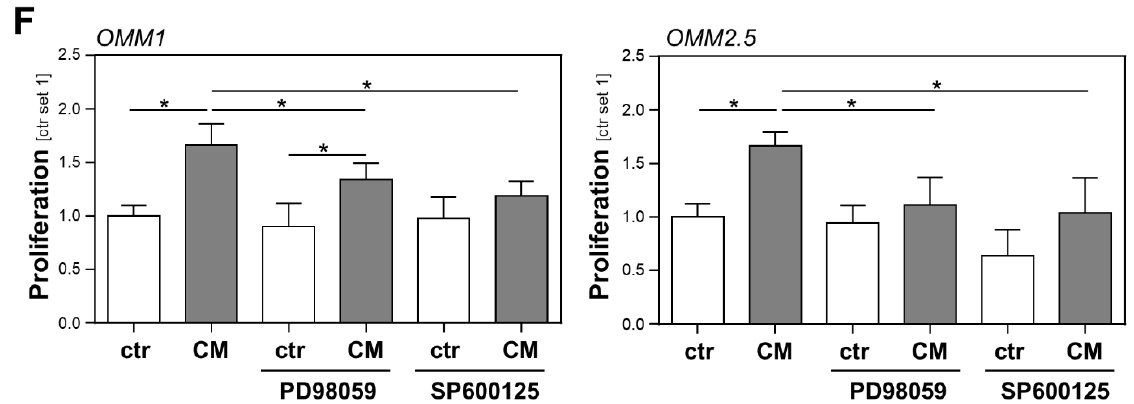
Figure 1. Interaction of activated hepatic stellate cells (HSCs) and uveal melanoma (UM) cells. ( A ) Hematoxylin and eosin staining of a hepatic metastasis tissue section of a patient with UM. The dashed line marks the fibrotic tissue that forms a border between the metastatic and liver tissue. Round white cavities in the liver cells represent lipid droplets and indicate that in this case, metastases developed in a slightly steatotic liver (scale bar: 200 µ m). ( B ) Immunohistochemical staining of the relevant liver tissue section as shown in panel A for alpha-smooth muscle actin ( α -sma), a specific marker for activated HSCs. The representative image shows the localization of HSCs in the fibrotic tissue surrounding the metastasis, as well as in its stroma (scale bar: 200 µ m). ( C ) Schematic illustration of the experimental design for simulating the interaction between HSCs and UM cells in vitro. UM cells were incubated with either conditioned medium (CM) from activated HSCs or the control medium (ctr). ( D ) Proliferation of UM cell lines OMM1 (left panel) and OMM2.5 (right panel) stimulated with HSC-CM or the control medium (ctr) for 48 h. ( E ) Western blot analysis of phosphorylated ERK and phosphorylated JNK in OMM1 and OMM2.5 cells that were treated with HSC-CM or the control medium (ctr.) for 1 h. ( F ) Effects of PD98059 (inhibitor of the MEK/ERK pathway; 2 µ M) and SP600125 (JNK inhibitor; 2 µ M) on the HSC-CM-induced proliferation of OMM1 cells (left panel) and OMM2.5 cells (right panel). Proliferation was assessed 48 h after the stimulation of cells (*: p <